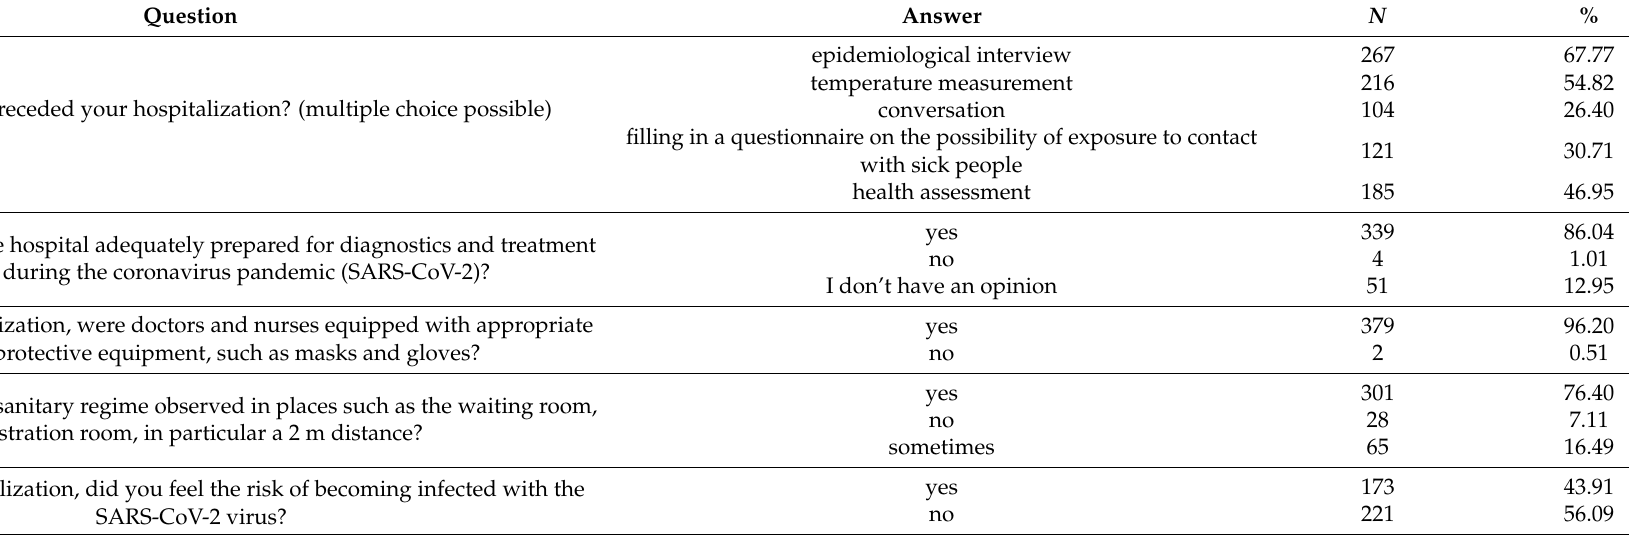
Table 2. Patient satisfaction with safety procedures in the oncology hospital during the COVID-19